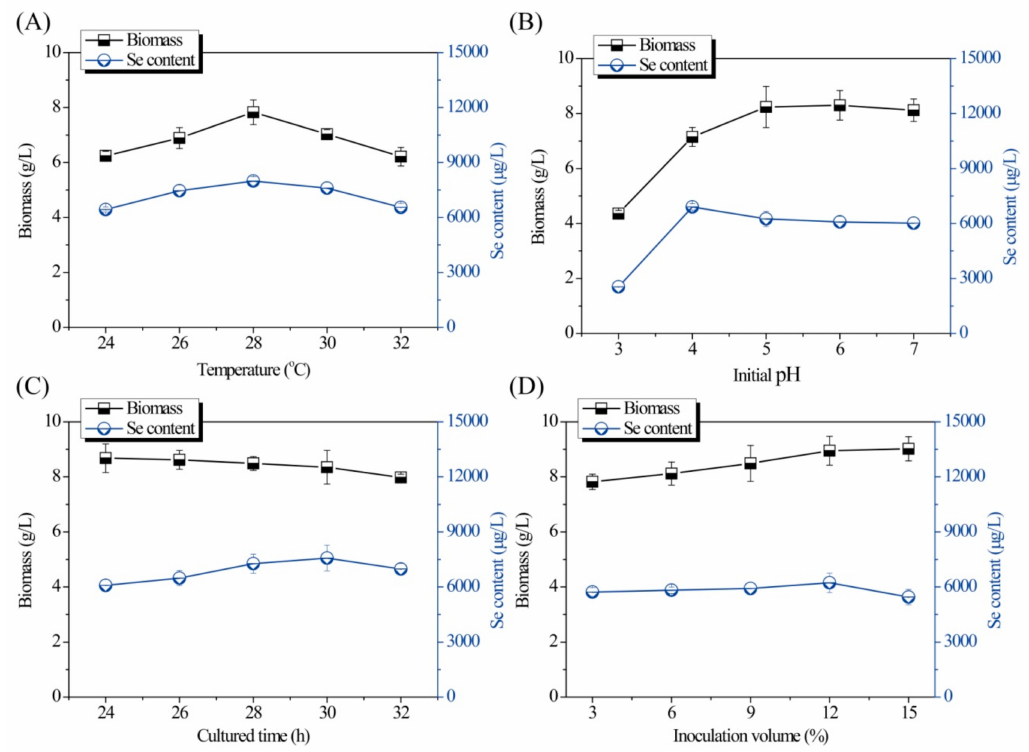
Figure 1. E ff ects of ( A ) temperature, ( B ) pH, ( C ) culture time, and ( D ) inoculation volume on Se content and biomass of Se-enriched discarded beer (DB)-yeast